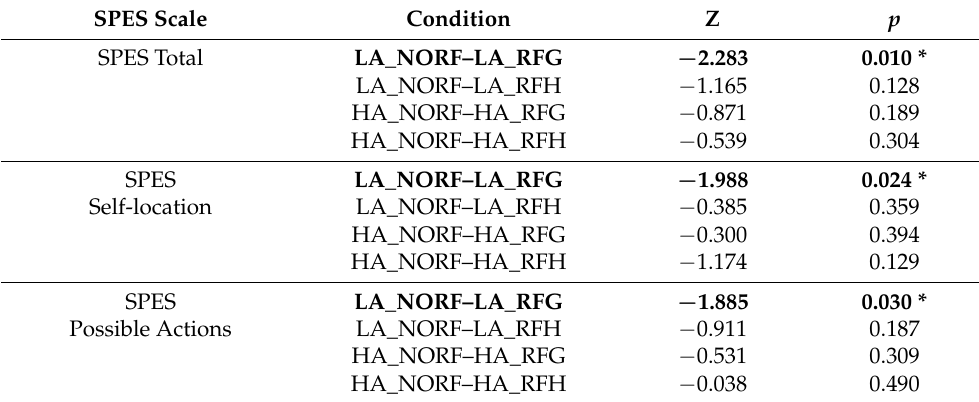
Table 9. Wilcoxon signed-rank test for presence—SPES scores between the no rest-frame and rest- frames